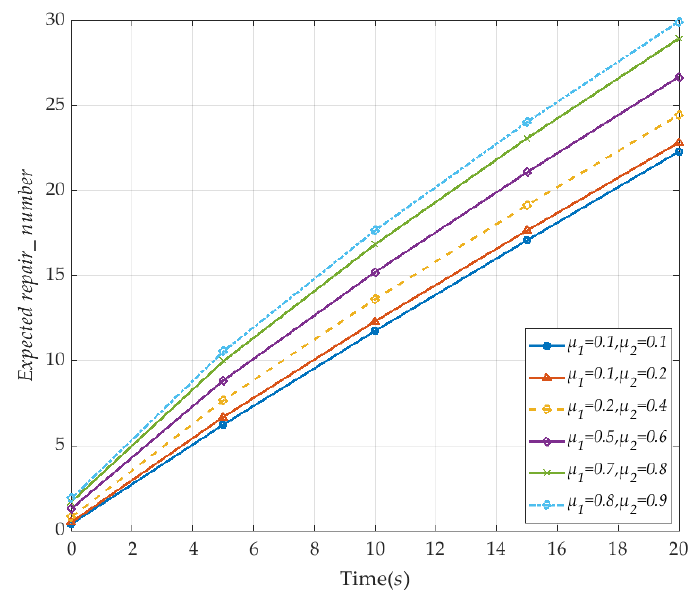
Figure 10. The instantaneous expected repair number of the the V2I network with time (corresponding to μ 1 and μ 2 ).